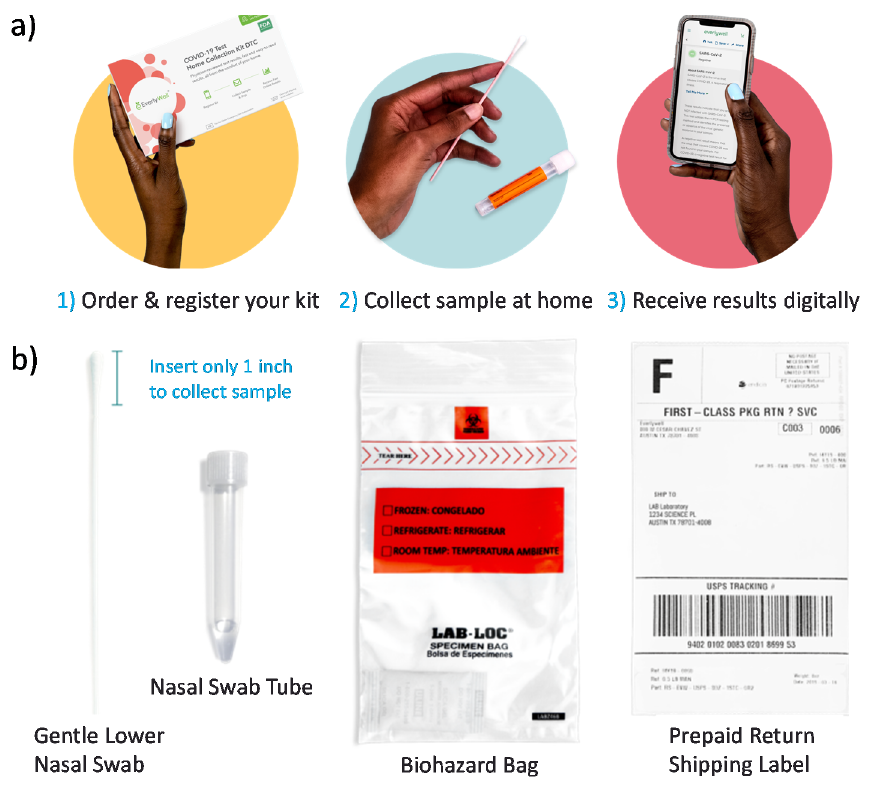
Figure 3. Everywell’s COVID-19 Test Home Collection Kit DTC (direct-to-consumer). ( a ) The procedure involves ordering the test kit, completing a health intake survey, registering the unique kit ID, self-collecting a nasal swab, shipping overnight to a CLIA-certified laboratory, and obtaining RT-PCR results within 24 to 48 h of the lab receiving the sample. A telehealth consult is available to follow up on the test results. ( b ) The Everywell test kit consists of a gentle lower nasal swab, nasal swab tube, biohazard bag, and prepaid shipping label. Images are reproduced and adapted with permission from Everywell [20].